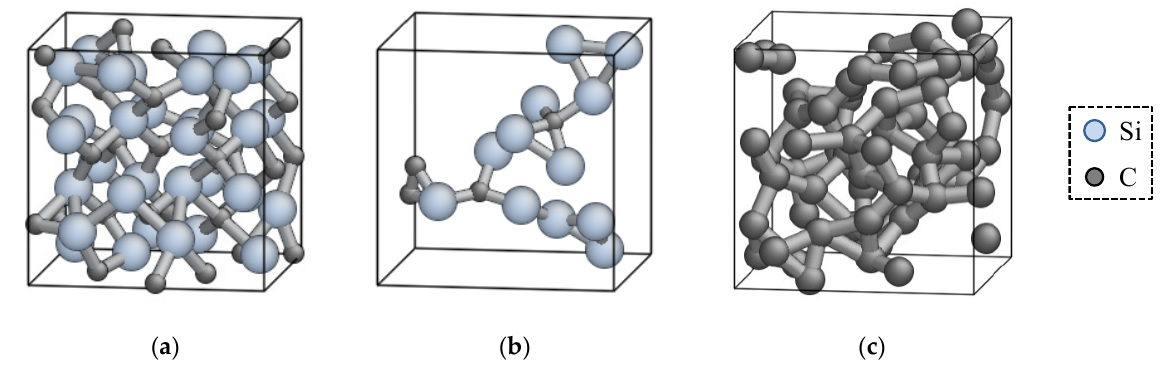
Figure 2. Example of reference structures obtained by MD simulation using provisional ANN potential functions. ( a ) 3C-SiC crystal near the melting point; ( b ) non-stoichiometric sparce Si-C system; ( c ) fused C system.